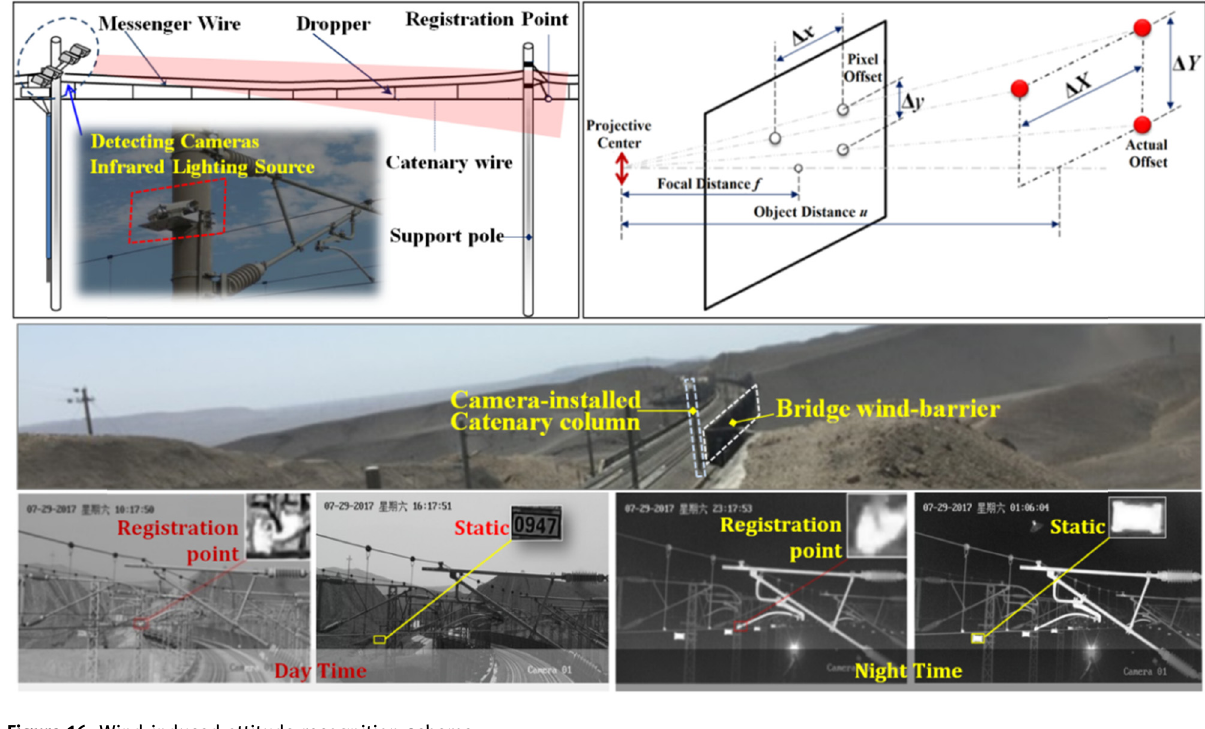
Figure 16: Wind - induced attitude recognition scheme.